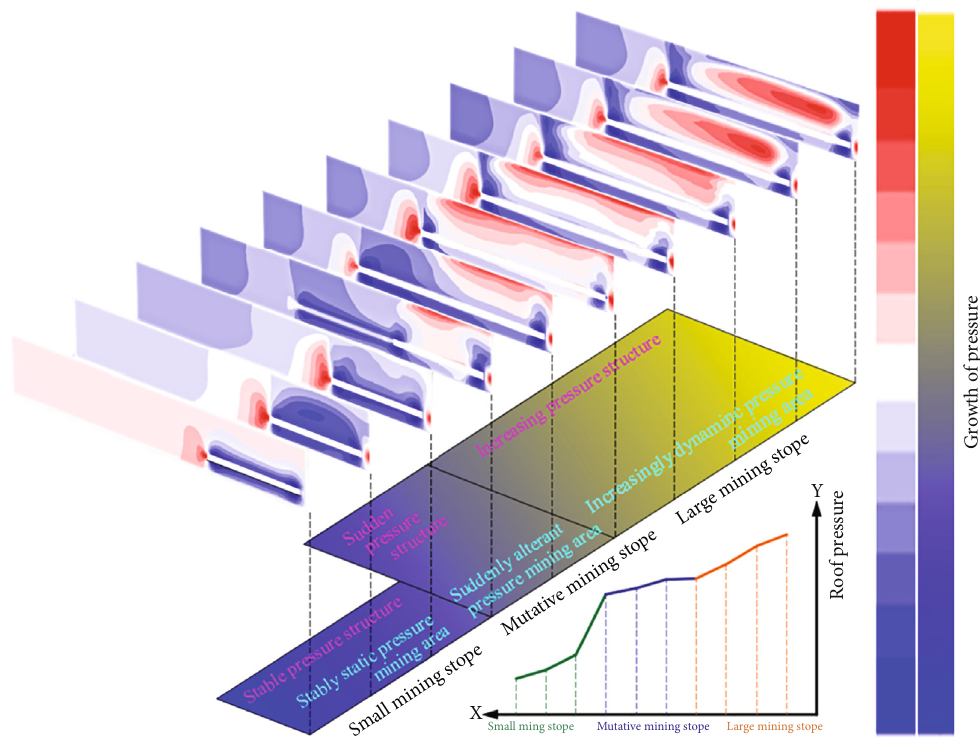
Figure 30: Pressure model of overburden structure of “ three stopes, three areas, and three structures. ”